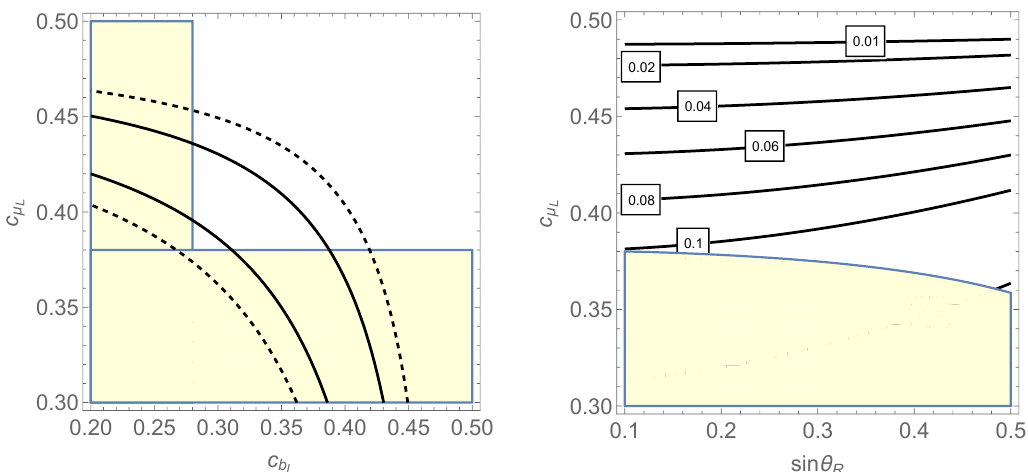
in the plane ( c b ; c (cid:22) ) using V d ’ V , at LL L L L in the plane (sin (cid:18) R ; c (cid:22) ) after selecting RL L